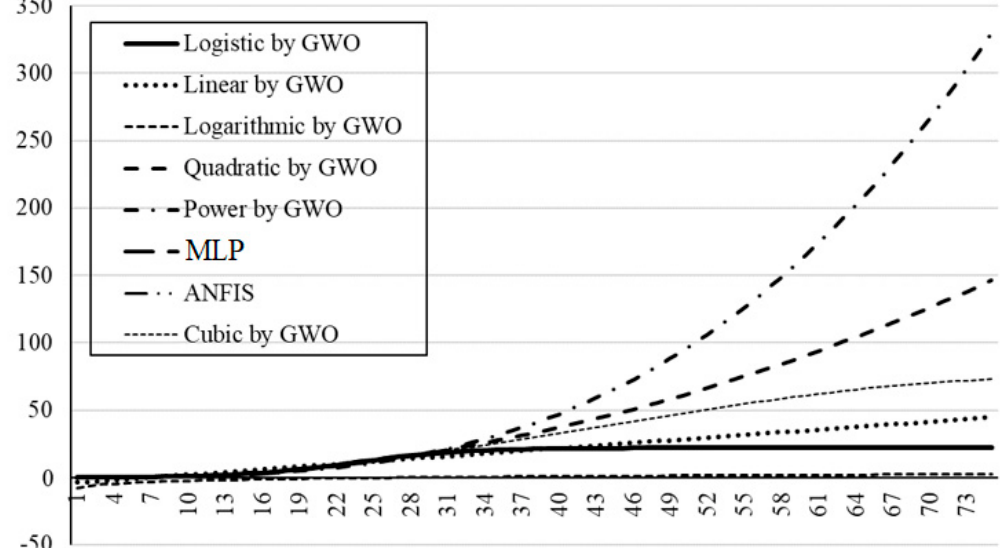
Figure 24. The outbreak prediction for Iran through 75 days.